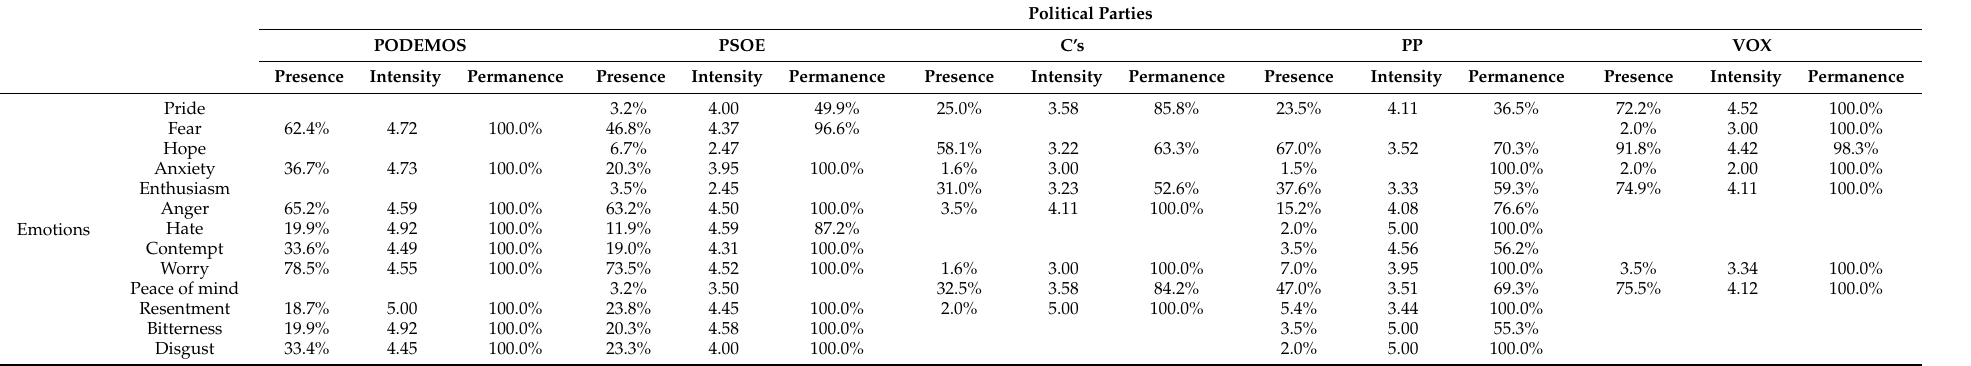
Table 2. Emotions of VOX voters towards political